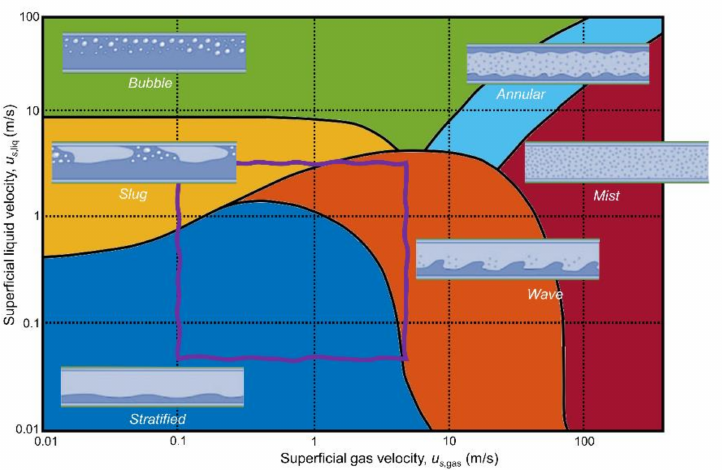
Figure 2. Schematic representation of a two-phase, gas-liquid flow map indicating the multiphase flow patterns likely to occur for a given combination of superficial flow velocities, adapted from [2]. The purple rectangle indicates the superficial gas and liquid flow velocities that can be obtained using the multiphase flow loop used in this